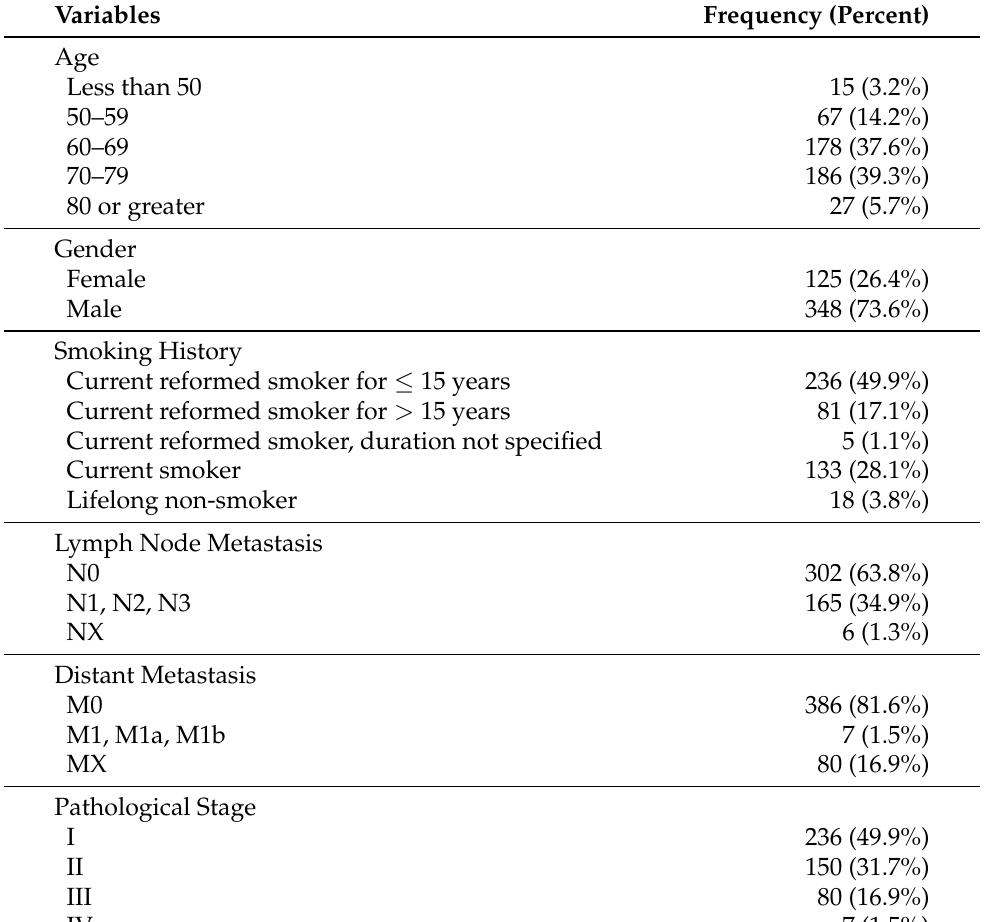
Table 1. Summary of clinical and pathological